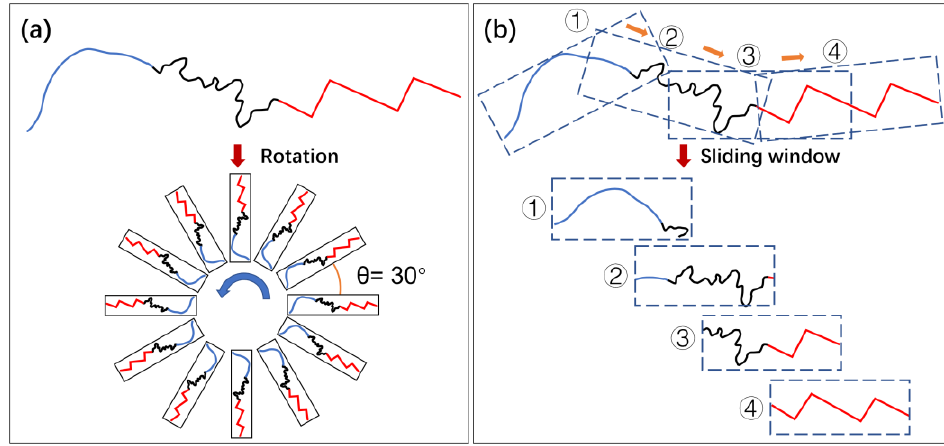
Figure 10. Two data augmentation methods for the training dataset: ( a ) rotation transformation method and ( b ) sliding window method.